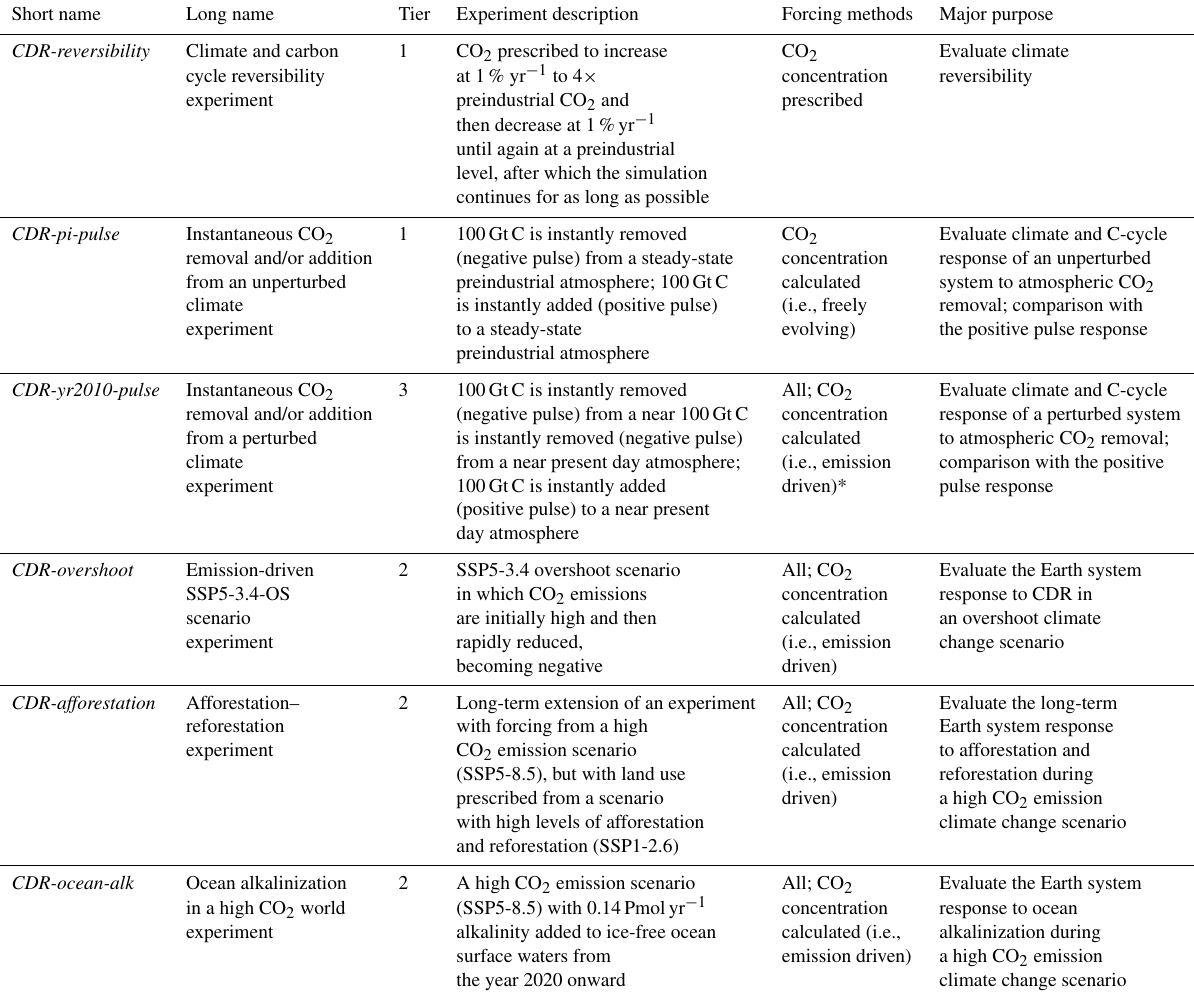
Table 1. Overview of CDRMIP experiments. Note that each experiment is comprised of several individually named simulations (Tables 2– 7). In the “Forcing methods” column, “All” means “all anthropogenic, solar, and volcanic forcing”. Anthropogenic forcing includes aerosol emissions, non-CO 2 greenhouse gas emissions, and land use